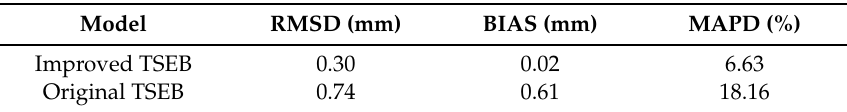
Figure 10. Mean daily ET for the tower locations derived from the improved TSEB, original TSEB, and EC tower. Table 2. Statistics of improved and original TSEB model-derived daily ET.